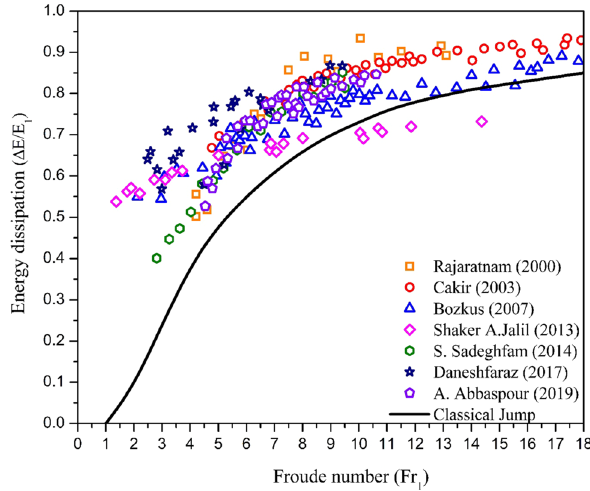
Fig. 1 Comparison of relative energy loss with respect to the Froude number ( F 1 ) as reported by the previous